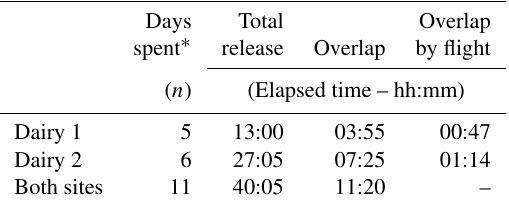
∗ Release on 25 June but no